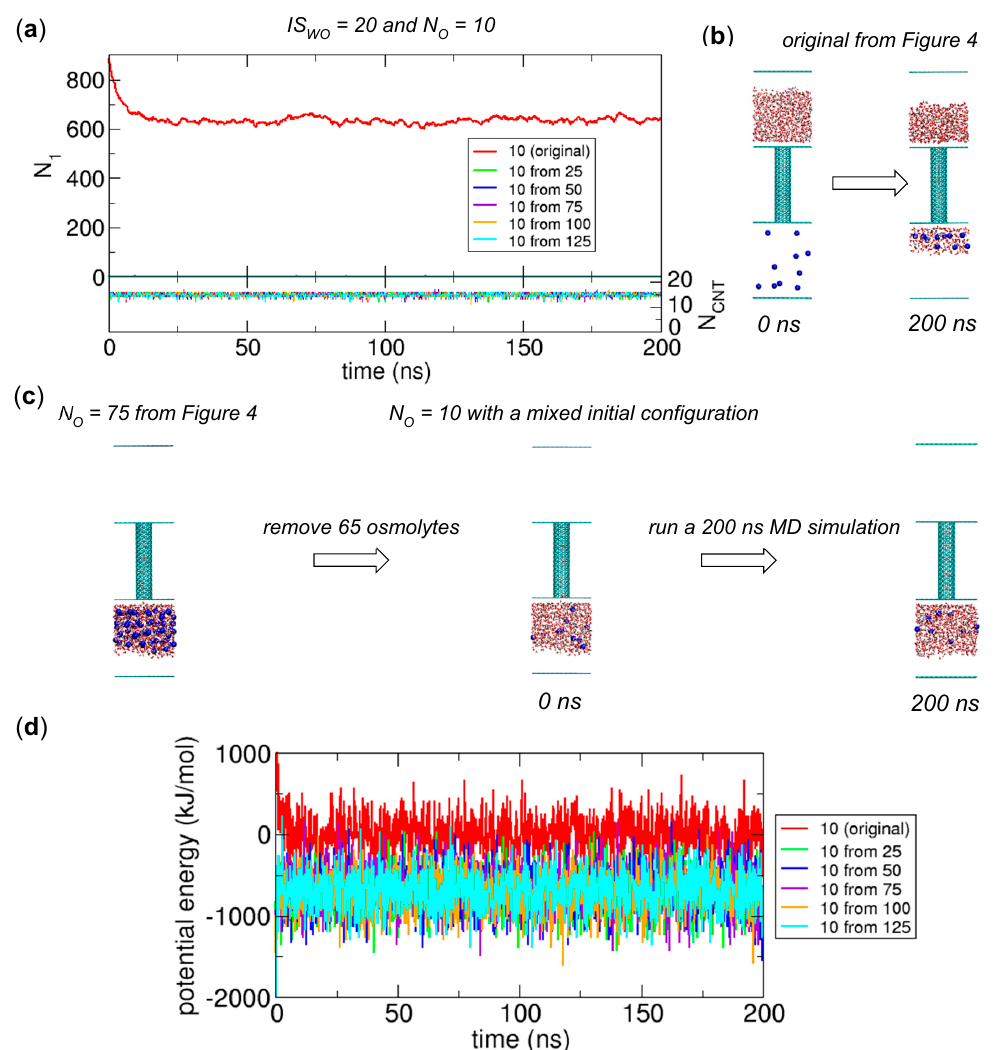
Figure 8. Equilibrium states for the case of N O = 10 and IS WO = 20 from the MD simulations with mixed initial configurations. The mixed initial configurations are prepared by removing some osmolytes from the final configurations at 200 ns in Figure 4 for the cases of N O = 25, 50, 75, 100, and 125 and IS WO = 20. ( a ) Numbers of water molecules in Compartment 1 ( N 1 ) and the CNT ( N CNT ) as functions of time for the cases with the original initial configuration (red) and mixed configurations (other colors). ( b ) Original initial configuration and final configuration at 200 ns obtained from the simulations in Figure 4. ( c ) Mixed initial configuration prepared from the final configuration with N O = 75 at 200 ns in Figure 4. ( d ) Changes in potential energy as functions of time. In this plot, the average value of the potential energy for the original case over the time interval from 100 to 200 ns is set to zero.